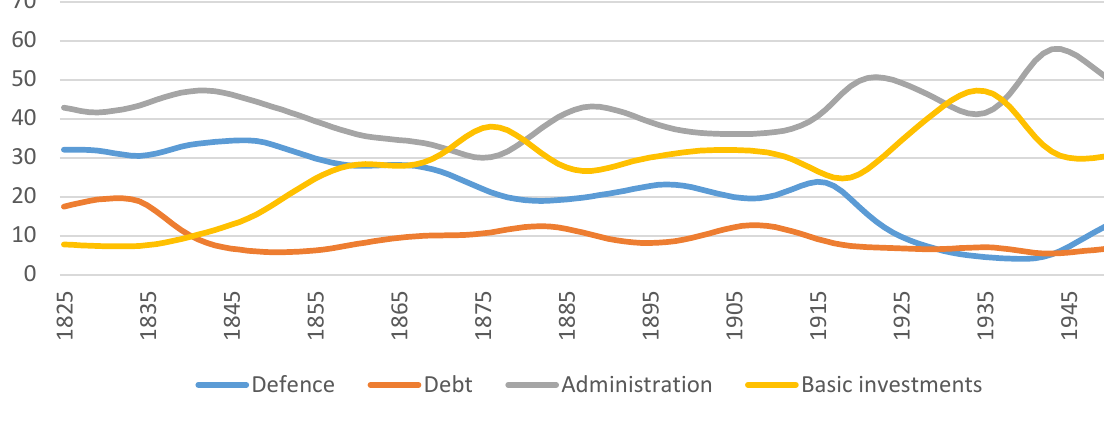
Figure 6. Central government spending by composition as share of total in percent, 1825–1950